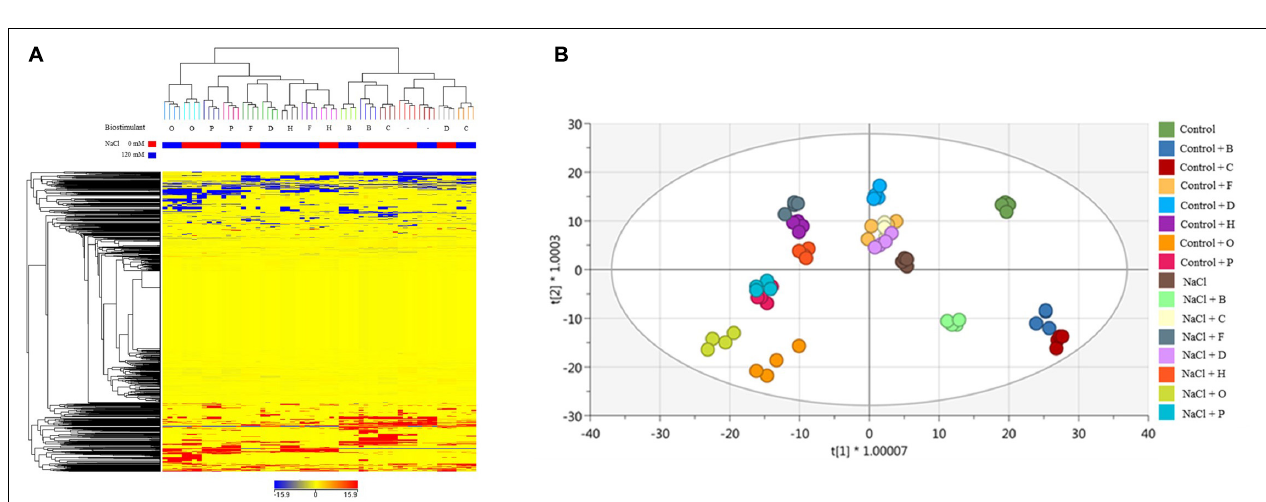
FIGURE 6 | Metabolomic analysis of tomato plants. Unsupervised hierarchical cluster analysis carried out from UHPLC-ESI/QTOF-MS metabolomics analysis of tomatoes treated with 7 PHs under control and salt stress (NaCl) conditions. The fold-change-based heat map was used to build hierarchical clusters (linkage rule: Ward, distance: Euclidean) (A) . Score plot of orthogonal projection to latent structures discriminant analysis (OPLS-DA) supervised modelling carried out on untargeted metabolomics profiles of lettuce plants after 7 PHs application, under control and salt stress (NaCl) conditions (R2Y = 0.98, Q2Y = 0.94) (B) .